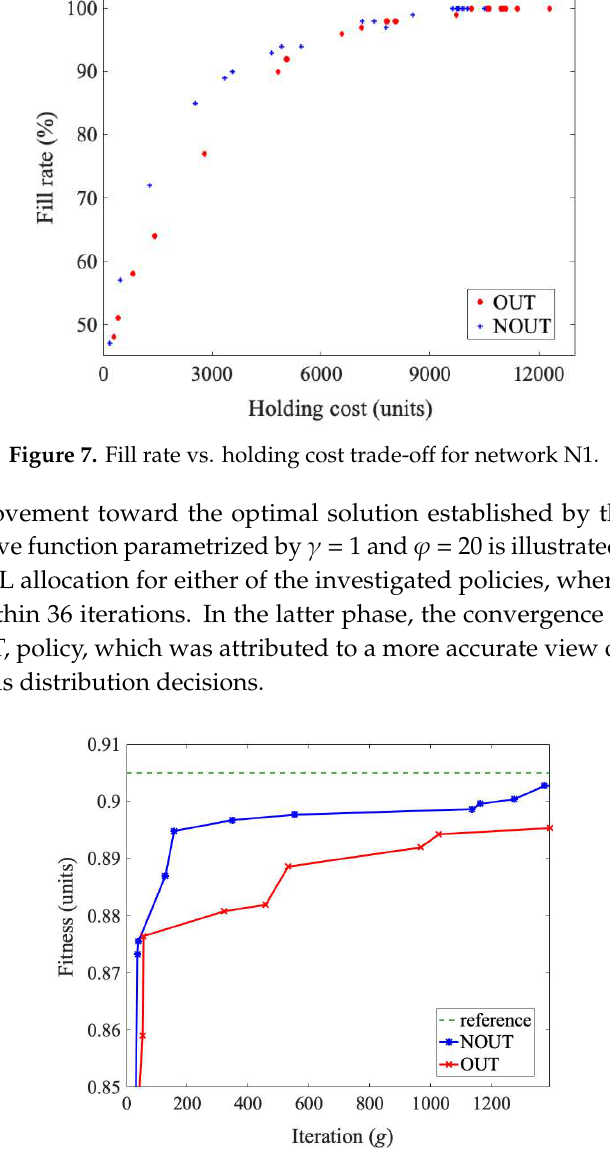
Figure 9. Goods distribution network N2.